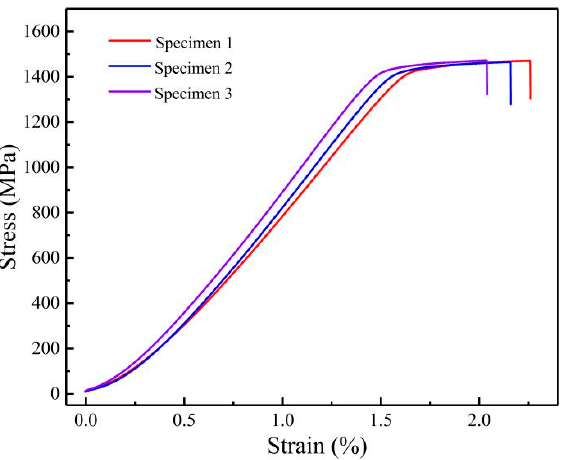
Figure 9. Tensile test results: forged Ti ‐ 6Al ‐ 10.9Cr alloy in β single ‐ phase solution treatment plus aging at 600 °C.